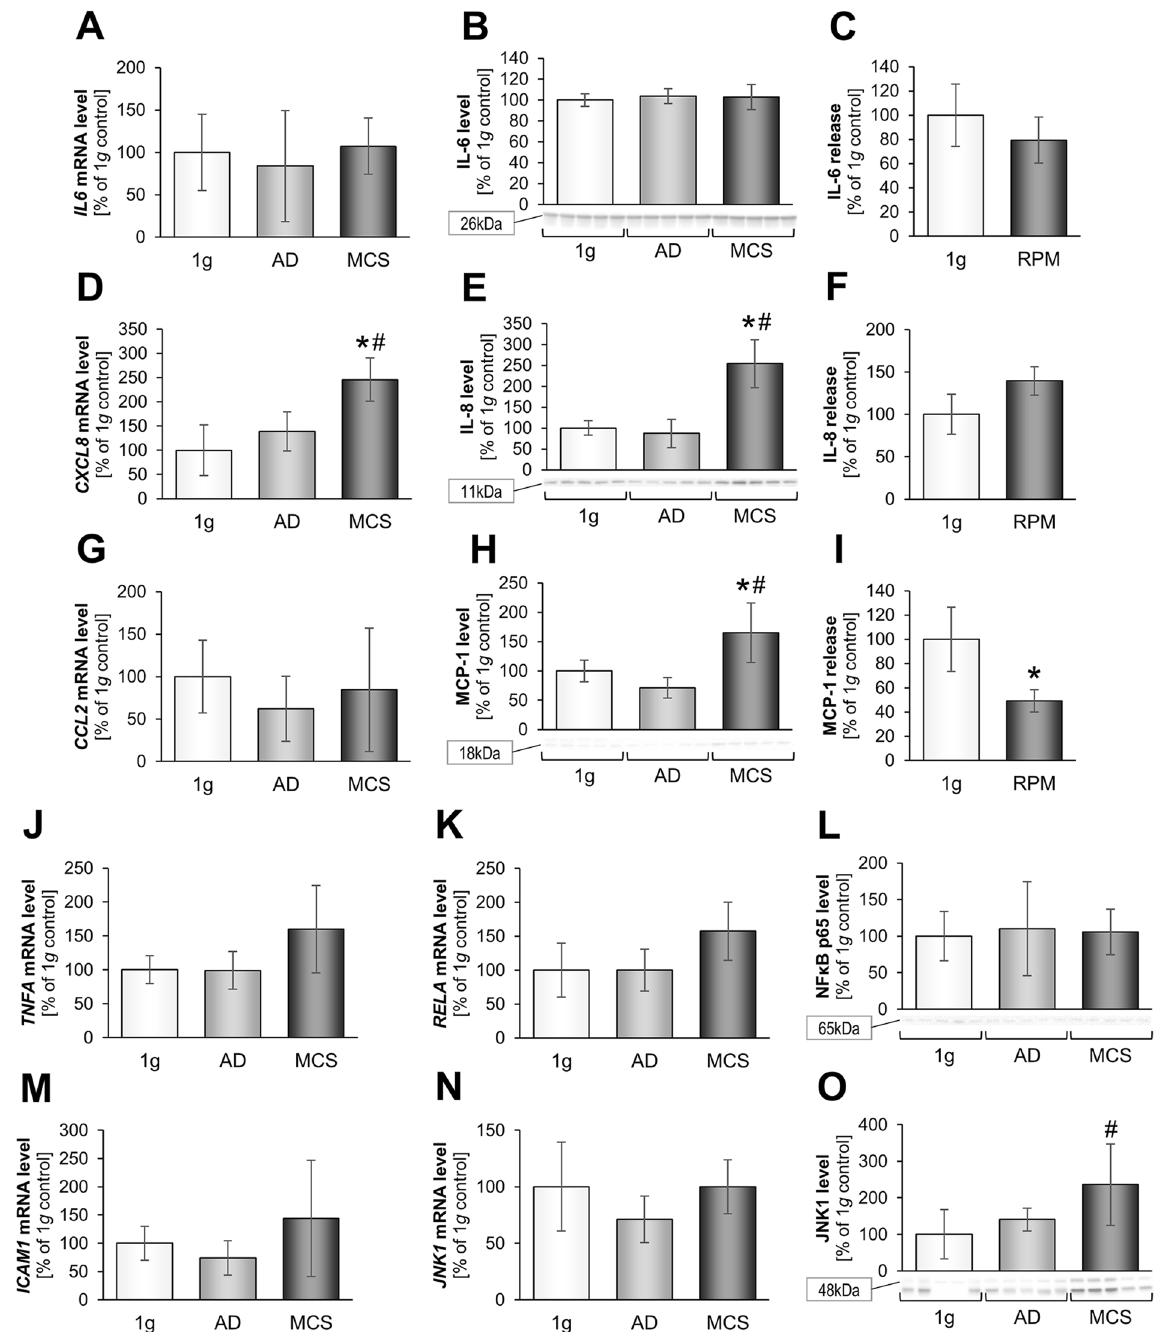
Figure 6. Analysis of selected cytokines after a 3-day s- µ g -exposure: Transcriptional and translational IL-6 analysis: Quantitative gene expression levels of IL-6 ( A ) and intracellular IL-6 levels ( B ), release of IL-6 ( C ). Transcriptional and translational IL-8 analysis: Quantitative gene expression levels of CXCL8 ( D ) and intracellular IL-8 levels ( E ), release of IL-8 ( F ). Transcriptional and translational MCP-1 analysis: Quantitative gene expression levels of CCL2 ( G ), intracellular MCP-1 levels ( H ), release of MCP-1 ( I ). Quantitative gene expression levels of TNFA ( J ). Transcriptional and translational NF- κ B p65 analysis: Quantitative gene expression levels of RELA ( K ) and intracellular NF- κ B p65 levels ( L ). Quantitative gene expression levels of ICAM1 ( M ). Transcriptional and translational JNK1 analysis: Quantitative gene expression levels of JNK1 ( N ) and intracellular JNK1 protein levels ( O ). Full-length blots of cropped Western blot images are presented in Supplementary Fig. S5. * p < 0.05 1 g vs. RPM; # p < 0.05 AD vs.